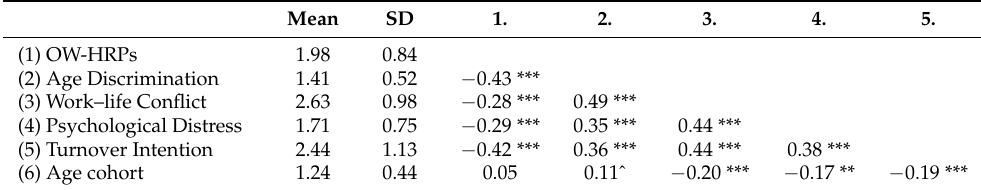
Table 3. Descriptive and correlations between variables.